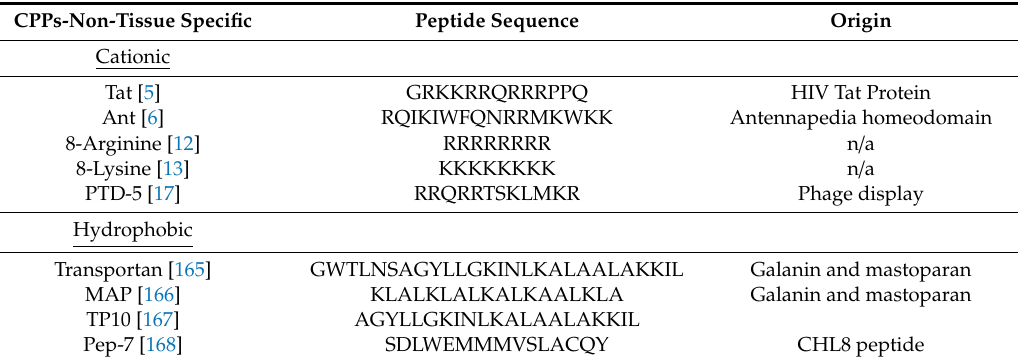
Table 1. Classification of Cell Penetrating